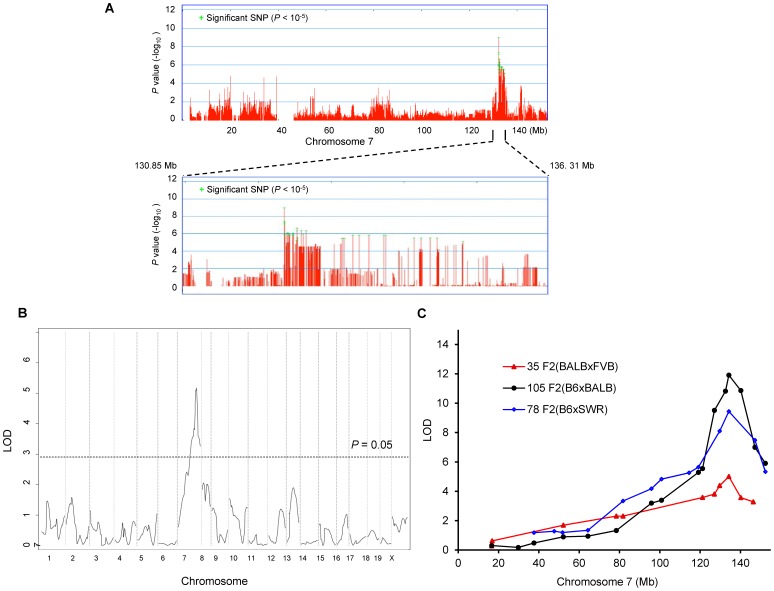

Civq1 on chromosome 7 re-identified in intercrosses between multiple mouse strains.A. Genome-wide EMMA analysis across chromosome 7 for cerebral infarct volume in 32 inbred mouse strains. The plot is drawn for −log(P) against SNP positions on the chromosome. Green crosses represent SNPs over the significance threshold of P = 10−5. The genomic region (132.35–134.81 Mb) with significant association in chromosome 7 maps within Civq1 detected by multiple linkage studies. B. The graph presents the results of a genome-wide linkage scan for infarct volume in 35 (FVB×BALB) F2 progeny. Chromosomes 1 through X are represented numerically on the x-axis and the y-axis represents the LOD score. The significant (P<0.05) level of linkage is determined by 1,000 permutation tests. Only a single genomic region on chromosome 7 displays significant linkage to infarct volume with a LOD score of 5.2. C. Civq1 is mapped to distal chromosome 7 by linkage analyses in multiple F2 (B6×BALB/c, B6×SWR, and FVB×BALB/c) populations. The same SNP marker (rs13479513) is located at the peaks of all linkage analyses.